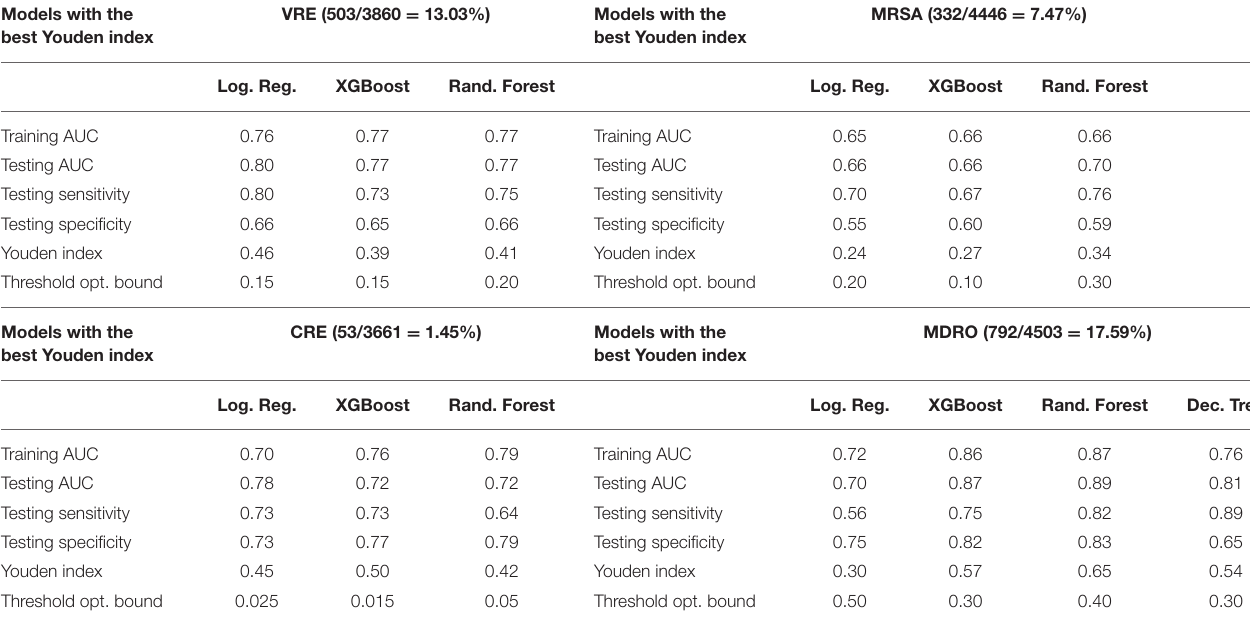
TABLE 5 | Performance summary of the supervised machine learning models with the highest Youden’s index. Models with the best Youden